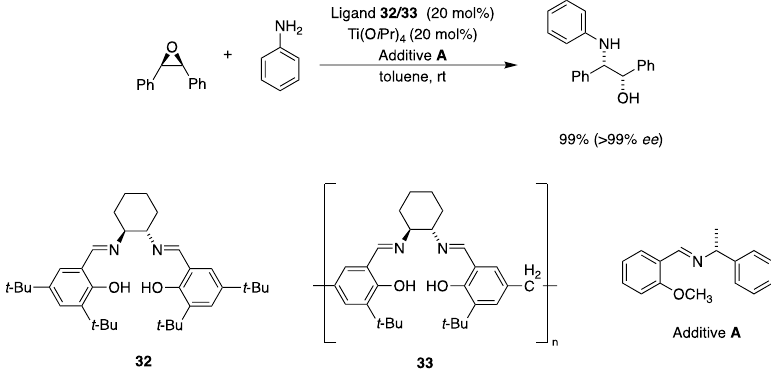
Figure 14. Macrocyclic Cr–salen complex 34 . Jacobsen and coworkers [57,58] used cyclic Co–salen catalyst 35 as a mixture of oligomers in the ARO of cyclic meso -epoxides with phenyl carbamate, resulting in the asymmetric synthesis of N - protected trans -1,2-amino alcohols in high yields and with excellent enantioselectivities (Scheme 10). For six-membered ring epoxides, the addition of the nucleophile was followed by intramolecular cyclization, resulting in trans -4,5-disubstituted oxazolidinone products. The ARO of five-membered ring epoxides also proceeded smoothly, although the products did not undergo cyclization, most likely due to the unfavorable strain in trans -fused 5-5 ring systems. The products could be deprotected by hydrolysis under basic conditions, and the method could be scaled-up to prepare multigram quantities of the products (Scheme 11).